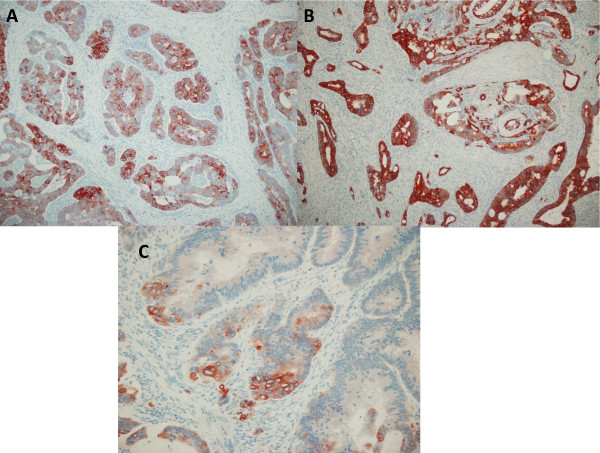
CK7 immunostaining in colonic, gastric, and pancreatic tumors. (A) Gastric and (B) pancreatic carcinomas showed diffuse and strong positive CK7 immunostaining. (C) Colonic adenocarcinoma displayed focal cytoplasmic immunoreactivity for CK7. (A)-(B), original magnification × 100; (C), original magnification × 200.